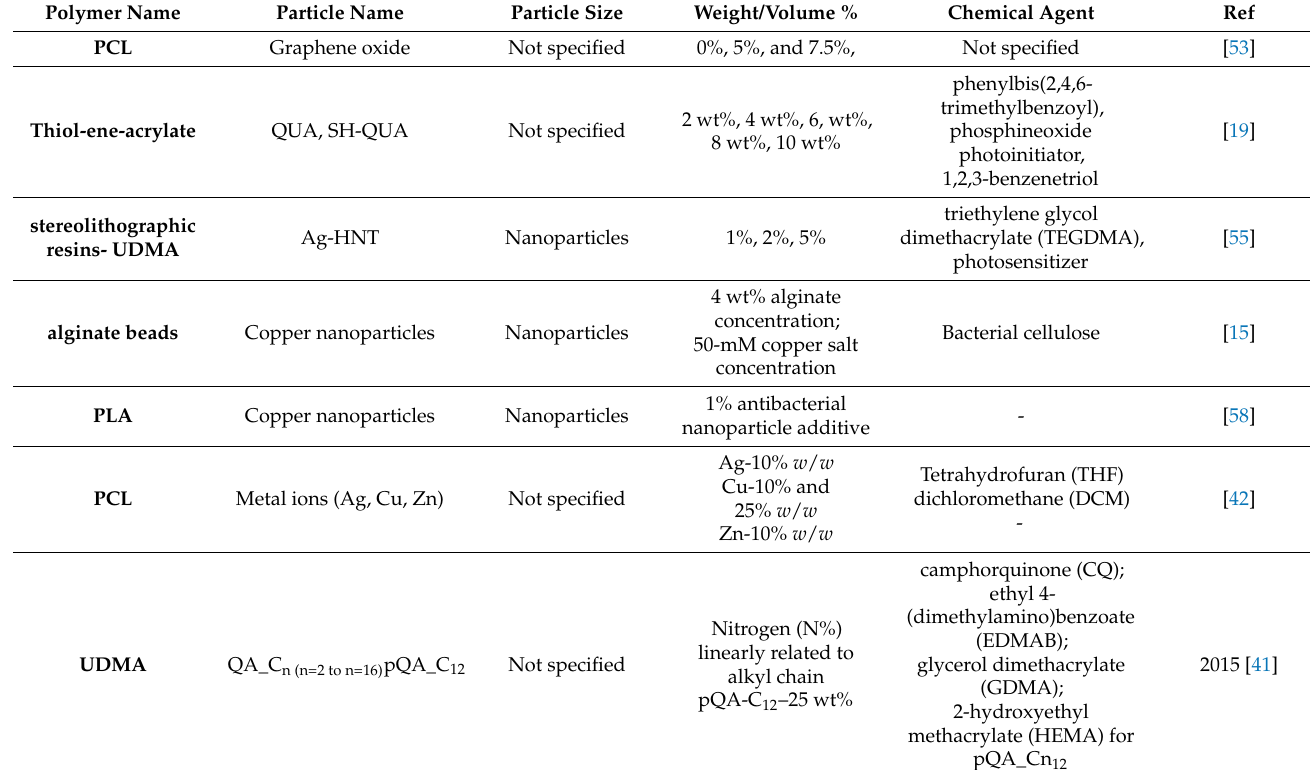
Table 1. Parameters used in selected studies in the 3D printing of antimicrobial material.